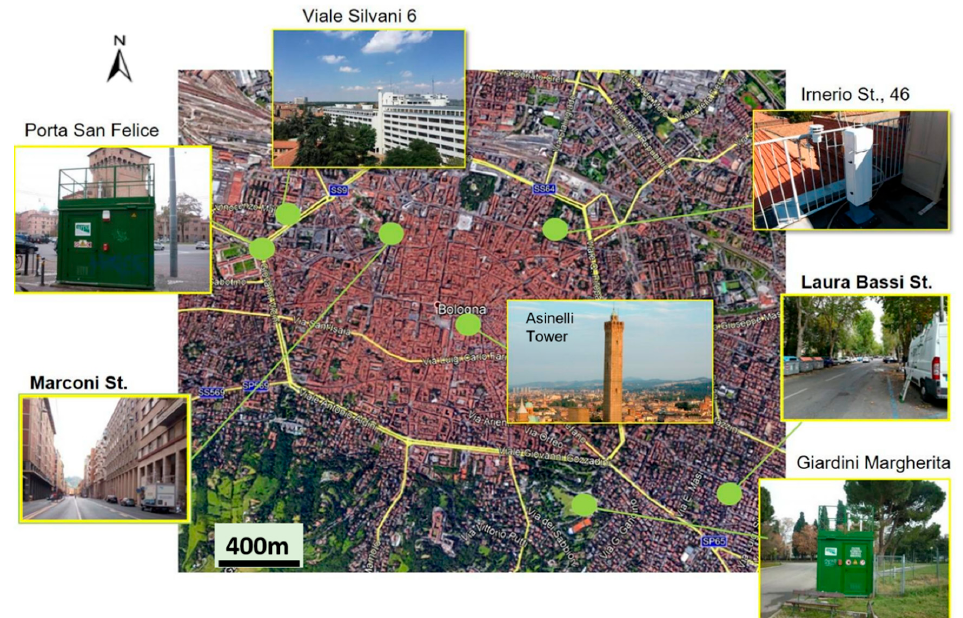
Figure 3. Monitoring sites network for the Bologna experimental campaigns (source: Google Earth).